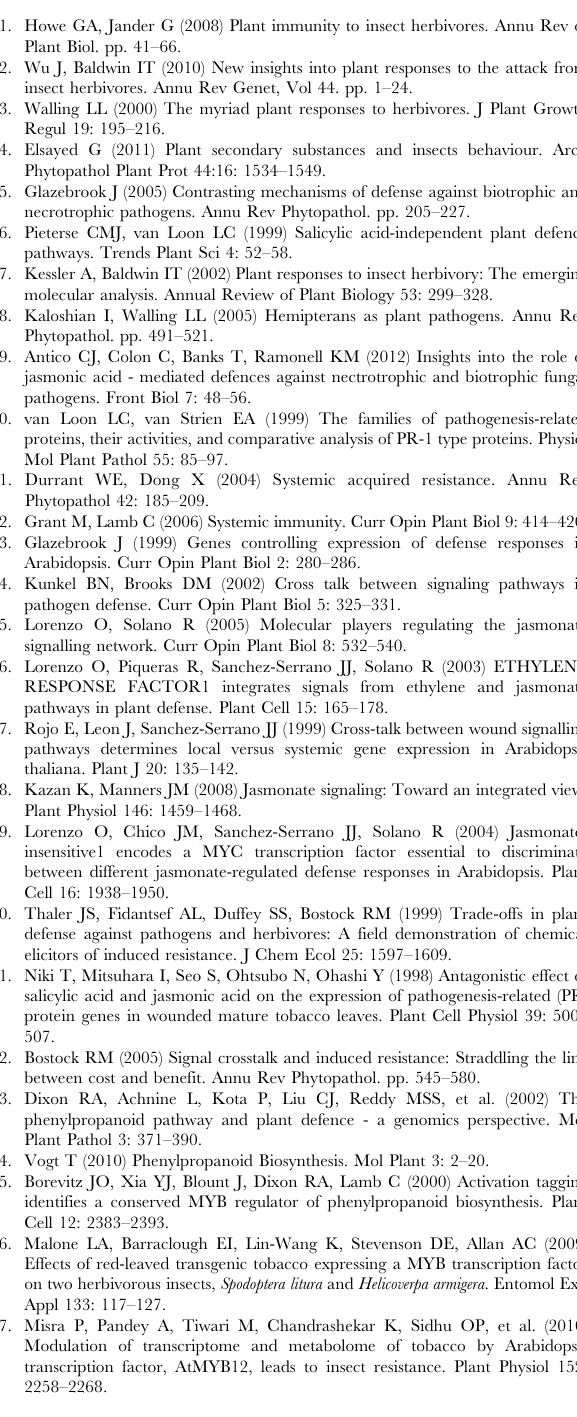
Figure S1. Chemical analyses of nicotine levels in WT and PAP green plants: non-infested (A) or after 5 days of B. tabaci infestation (B).